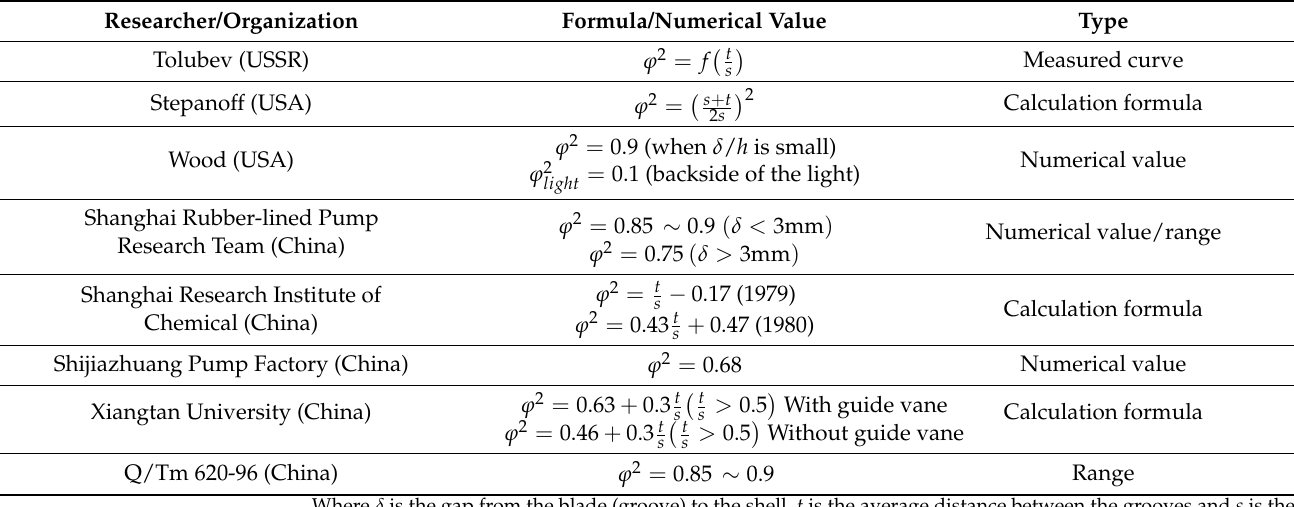
Table 6. Empirical formulas of pressurization coefficients of some researchers.